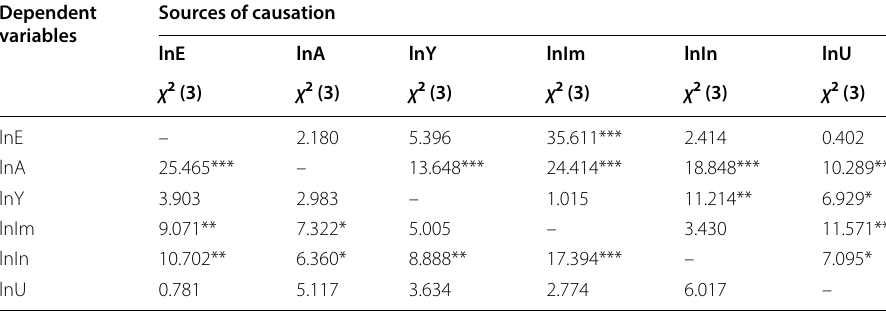
Statistically significant at 1% (***), 5% (**) and 10% (*) level